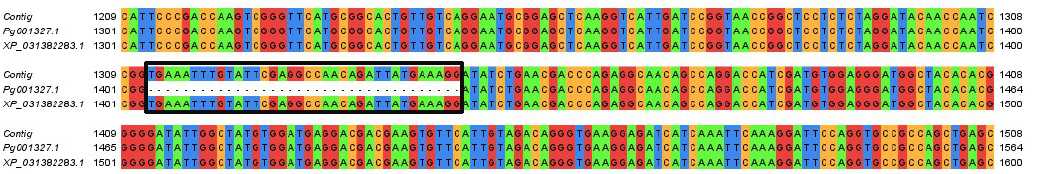
Figure 3. Multiple alignments of Pg001327.1 , XP_031382283.1 and sequencing results. This square